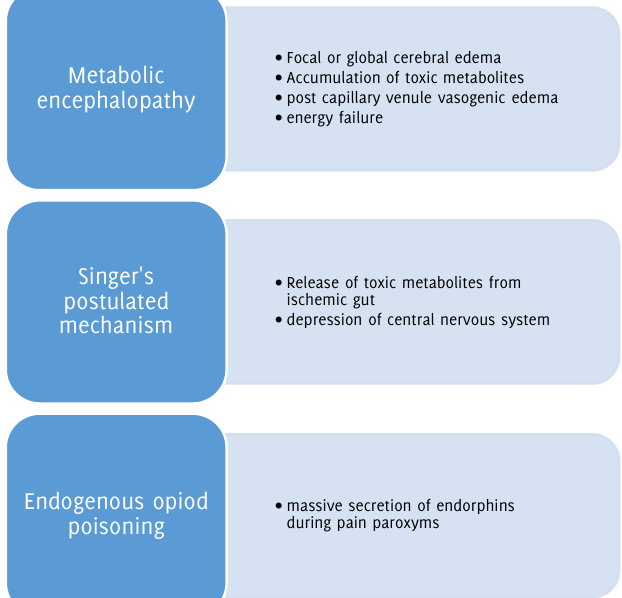
Figure 3 . Hypothetical mechanisms causing Intussusception